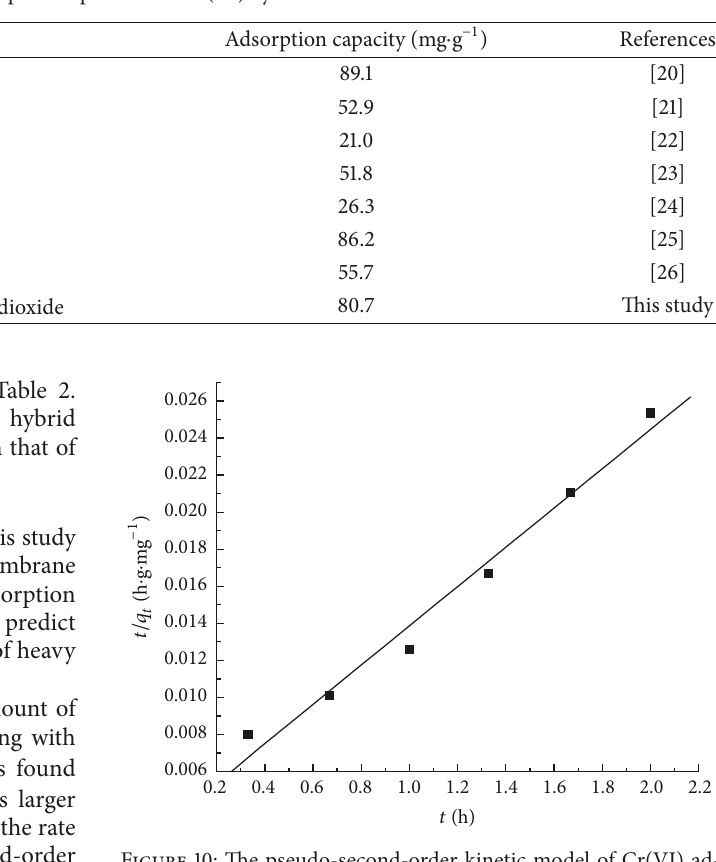
Table 2: Comparison of adsorption capacities for Cr(VI) by different adsorbents.